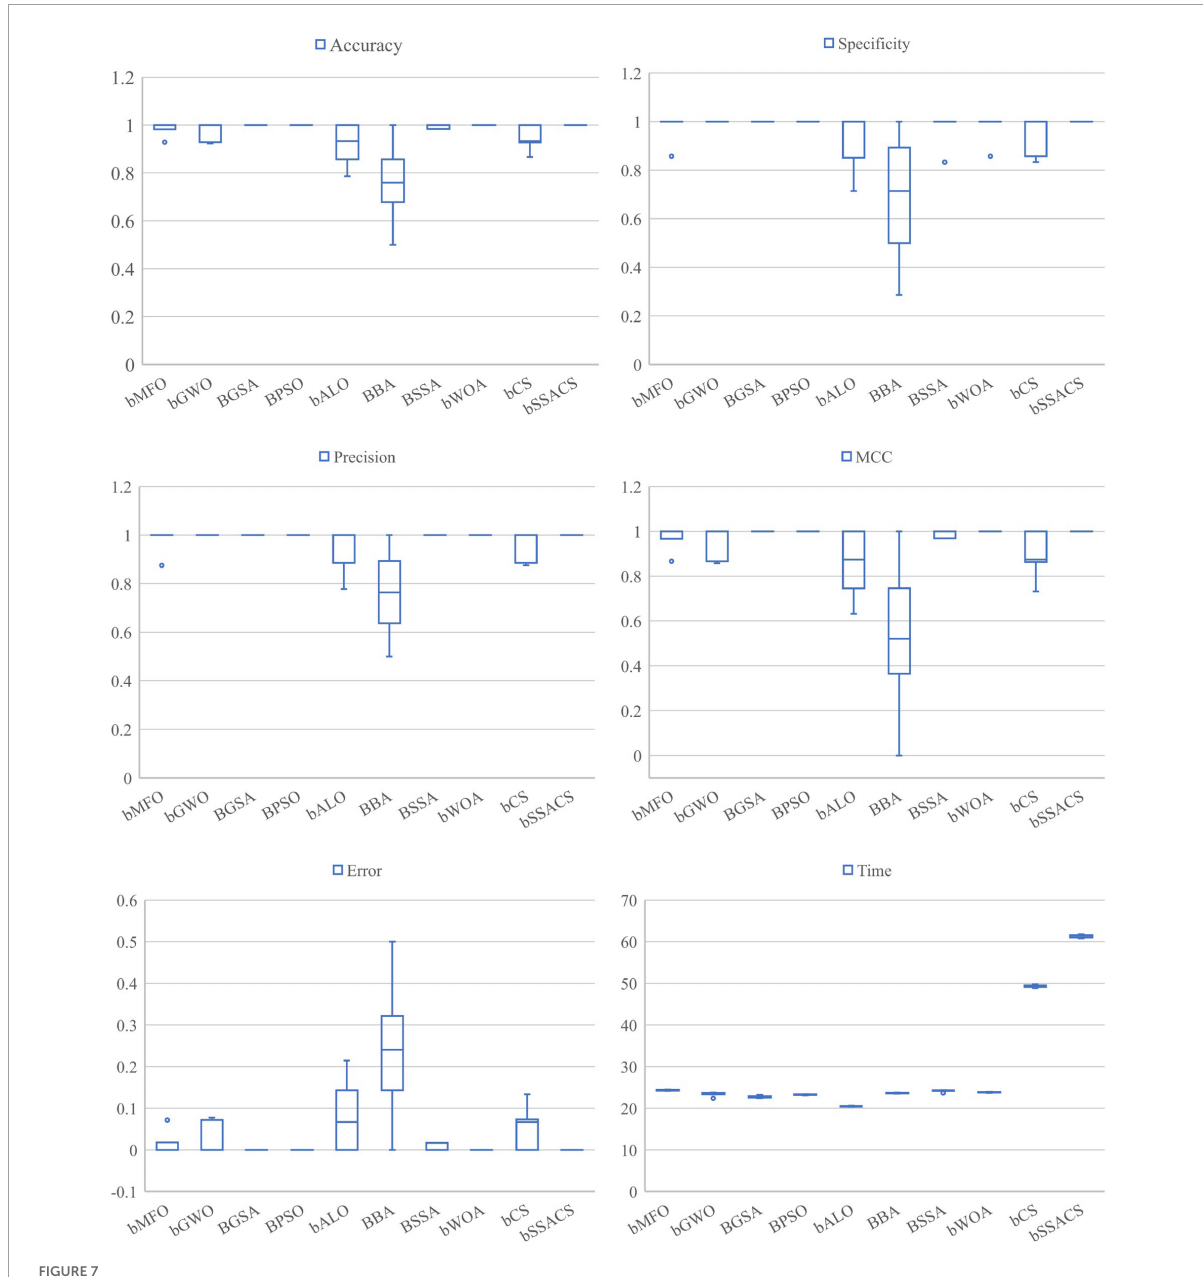
FIGURE7 Comparison of SSACS and eight algorithms on six evaluation